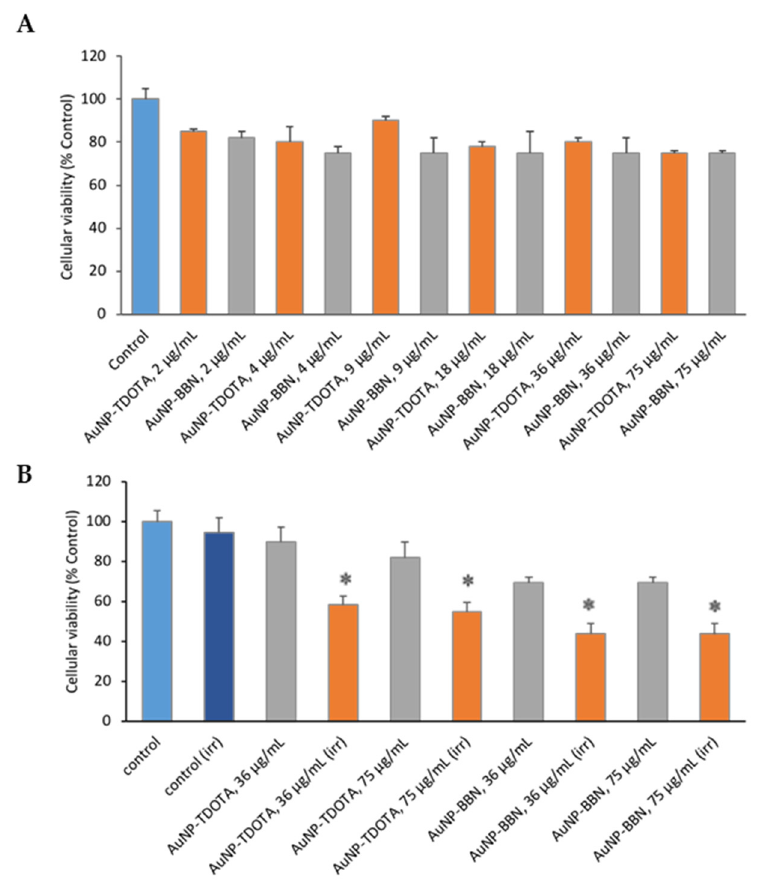
Figure 3. ( A ) Cellular viability of PC3 cells after 4 h of incubation with the AuNPs ( AuNP-TDOTA and AuNP-BBN ) at different gold concentrations (2–75 µg/mL). ( B ) Cellular viability before and after irradiation at 2 Gy for selected concentrations. The MTT assay was performed 72 h after irradiation. For comparison, the same procedure was followed for the non-irradiated cells. Statistical significance was calculated using two-tailed Student’s t -test with non-irradiated cells as the control (* p ≤ 0.05). Data are expressed as the percentage of cellular viability (mean ± SD).